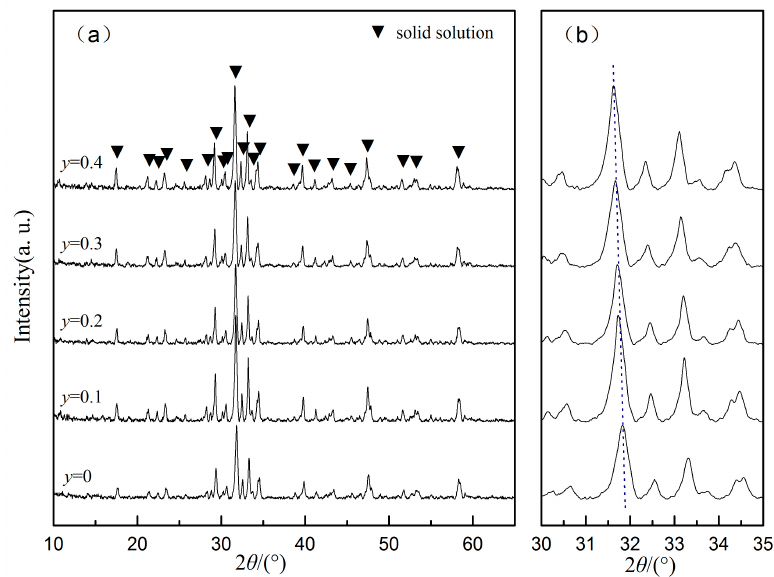
Figure 1. XRD di ff raction patterns of Ba 6 − 3 x (Sm 1 − y Nd y ) 8 + 2 x Ti 18 O 54 ( x = 2 / 3, y = 0, 0.1, 0.2, 0.3, 0.4) Figure 1. XRD diffraction patterns of Ba 6 − 3 x (Sm 1 − y Nd y ) 8+2 x Ti 18 O 54 ( x = 2/3, y = 0, 0.1, 0.2, 0.3, 0.4) ceramics sintered at 1400 ◦ C for 2 h: ( a ) patterns for 2 θ from 10 to 65 ◦ and ( b ) partial enlarged detail of ceramics sintered at 1400 °C for 2 h: ( a ) patterns for 2 θ from 10 to 65° and ( b ) partial enlarged detail XRD patterns around 2 θ = 31.7 ◦ . of XRD patterns around 2 θ = 31.7°.